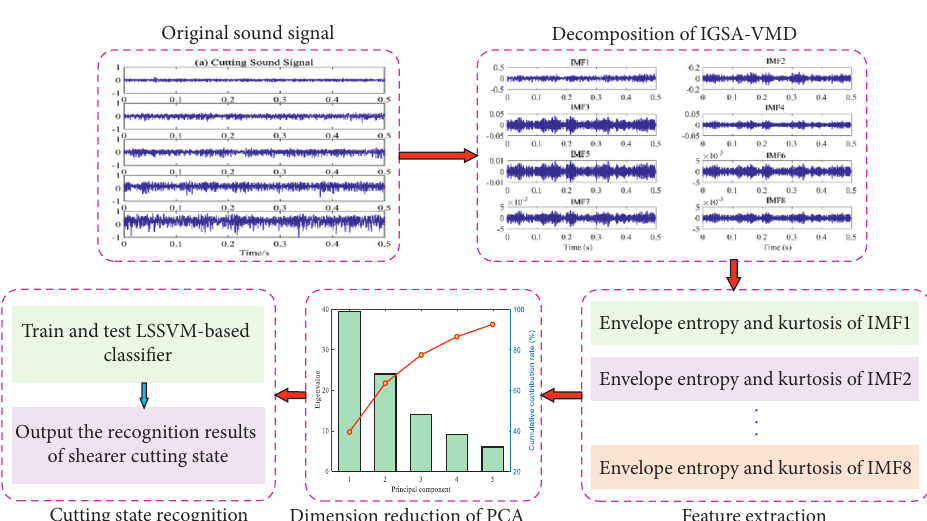
Figure 8: The main point of the proposed shearer cutting state recognition